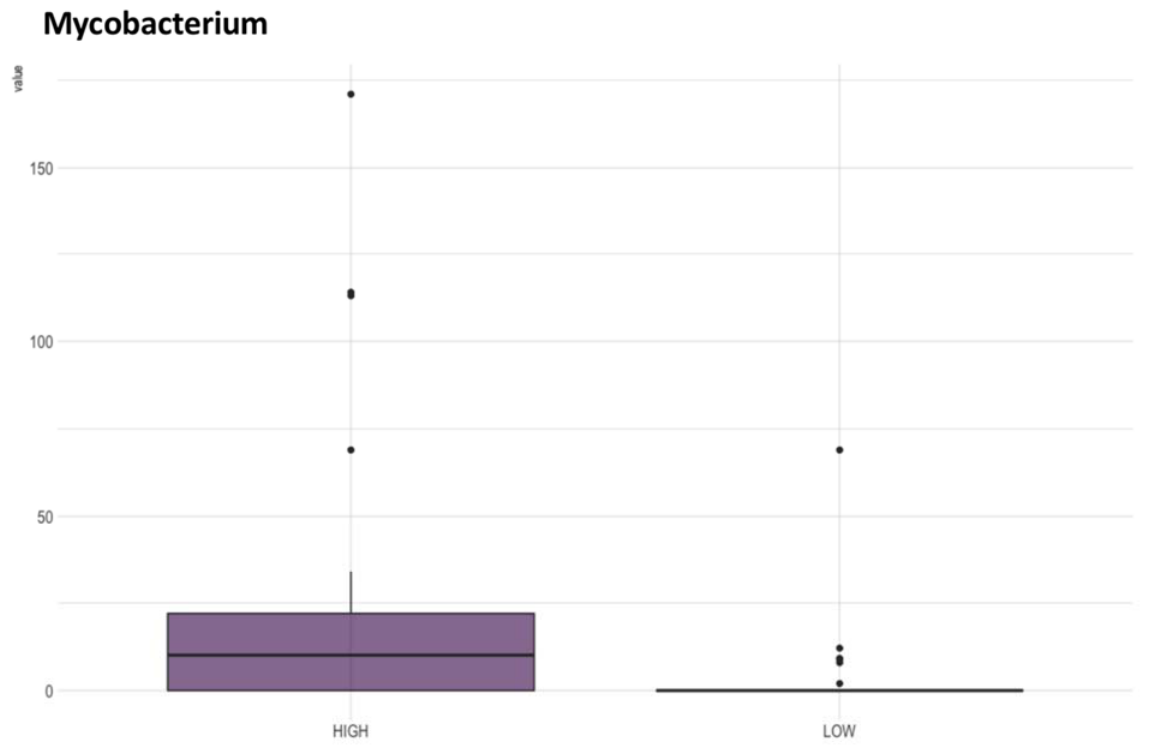
Figure 3. Box plots of ANCOM analysis of water samples according to high or low alkalinity .